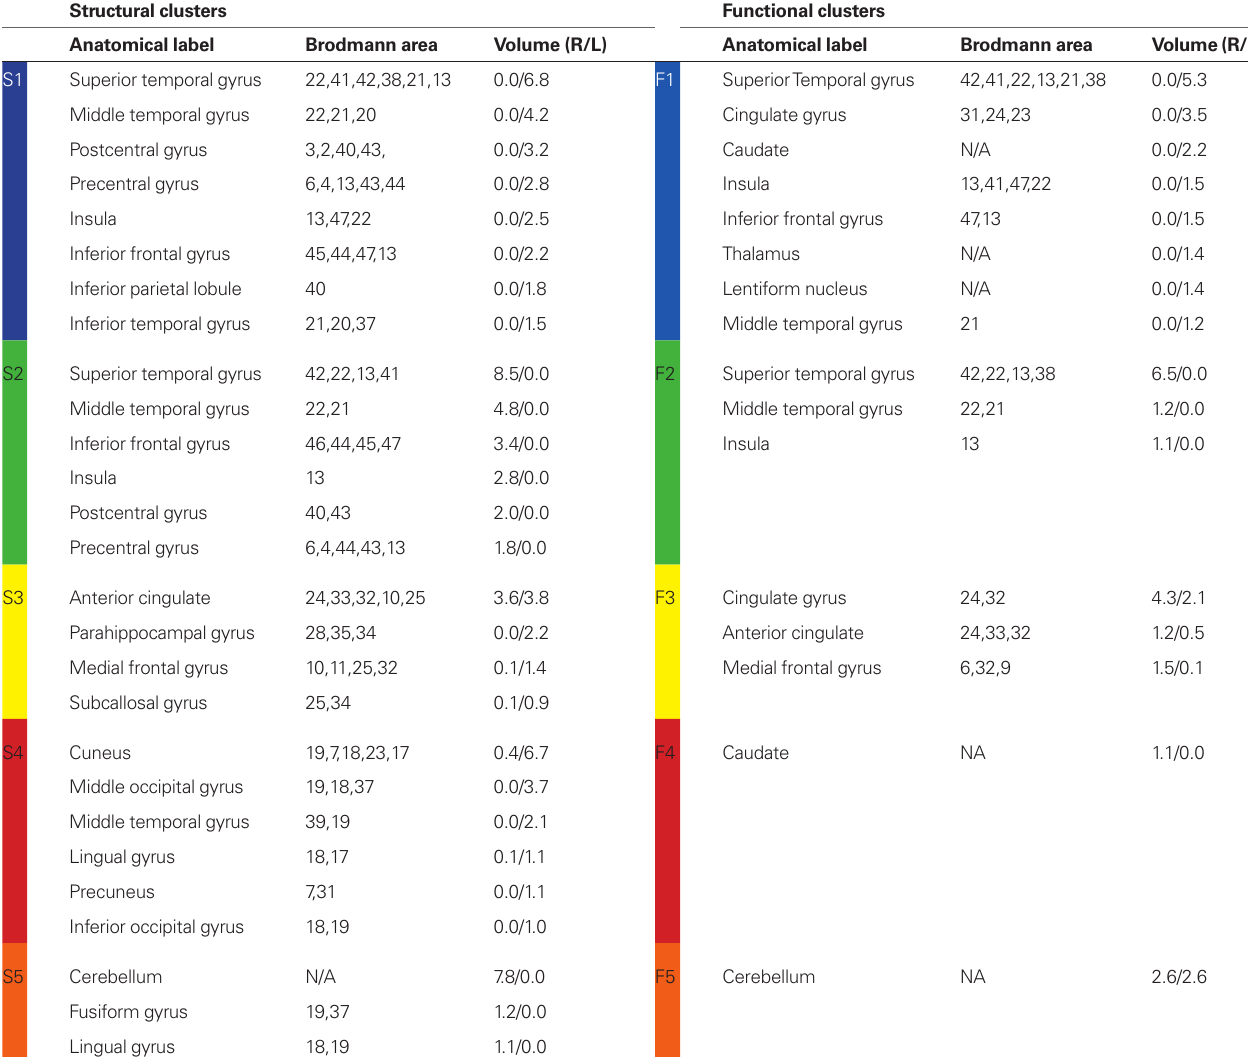
Table 3 | Anatomical labels of structural and functional